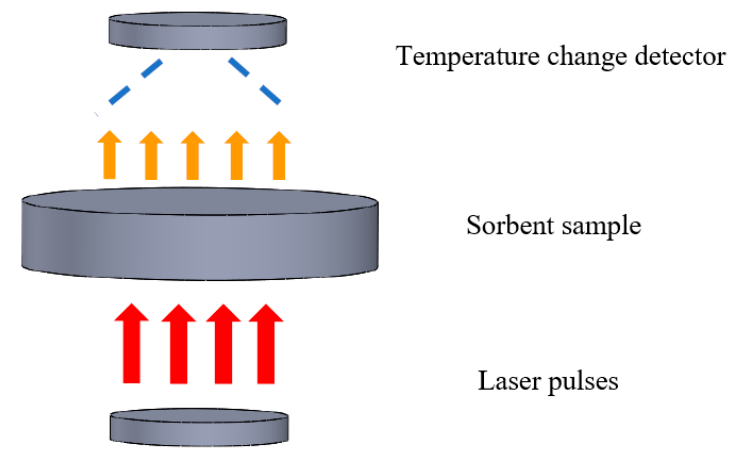
Figure 1. The operating principle of the laser flash method apparatus. Table 2. Parameters for the measurement of thermal di ff usivity.